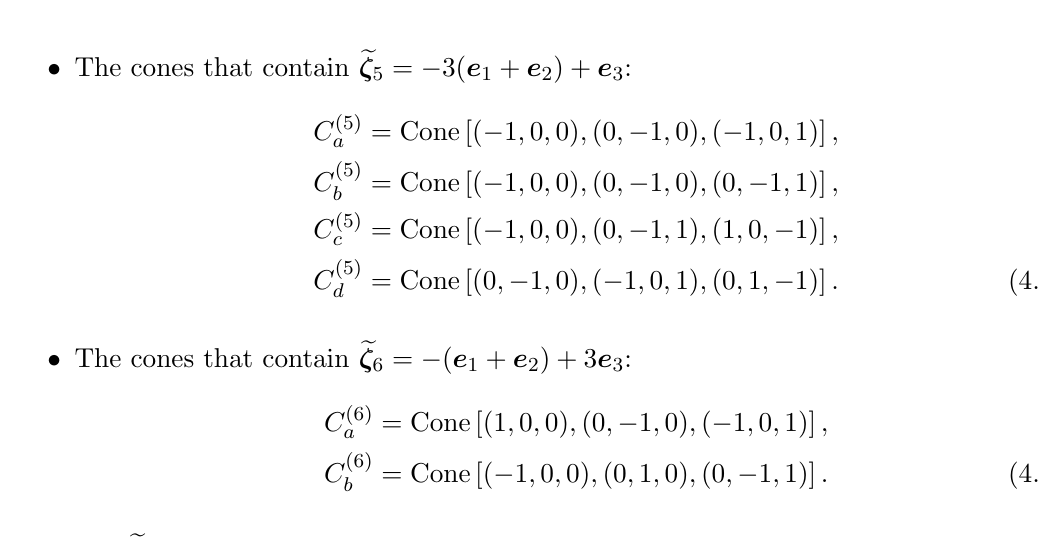
Figure 14 . A brane con(cid:12)guration for the ’t Hooft operator with the magnetic charge B = (cid:0) e 1 + 2 e N